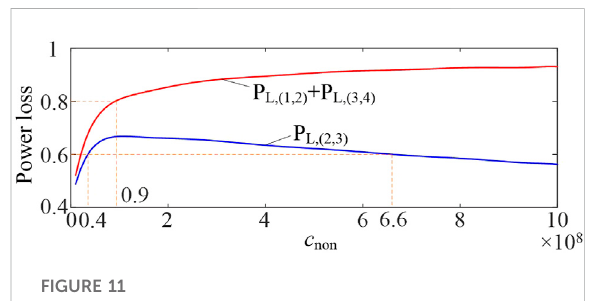
FIGURE 11 Power loss of the nonlinearly damped 4-DoF